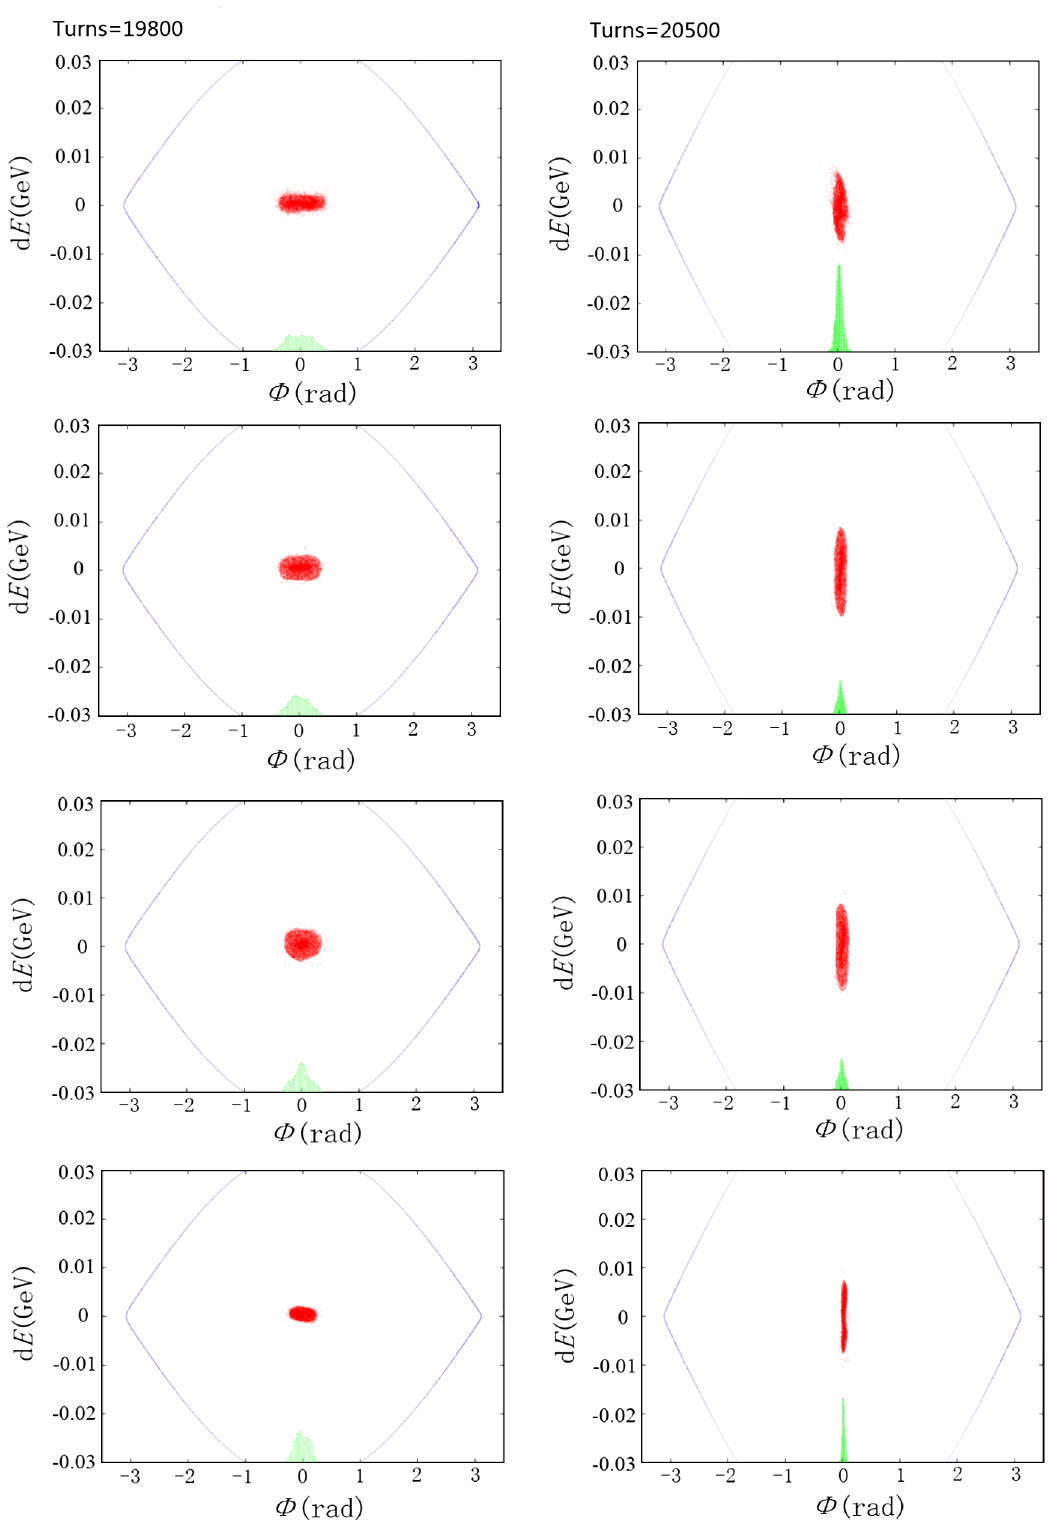
FIG. 3. Longitudinal beam distributions just before the extraction with different beam powers and chopping factors (Left: without bunch compression. Right: with bunch compression. Top to bottom represent modes A, B, C, and D,